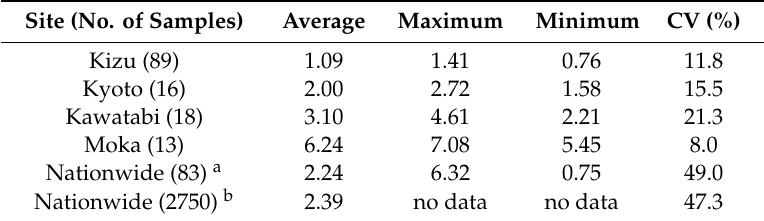
Table 3. Descriptive statistics of the soil total N content (g kg − 1 ) at each farm. Site (No. of